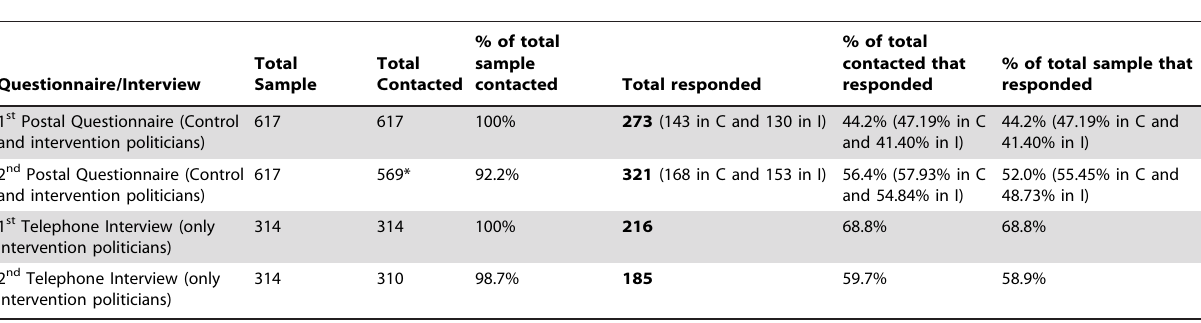
Table 1. Response numbers and rates for all questionnaires and interviews with politicians.